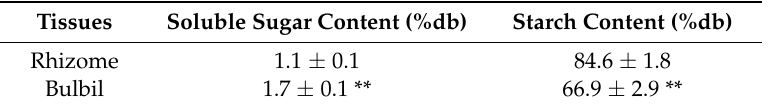
Table 1. Soluble sugar and starch contents in dry rhizome and bulbil a